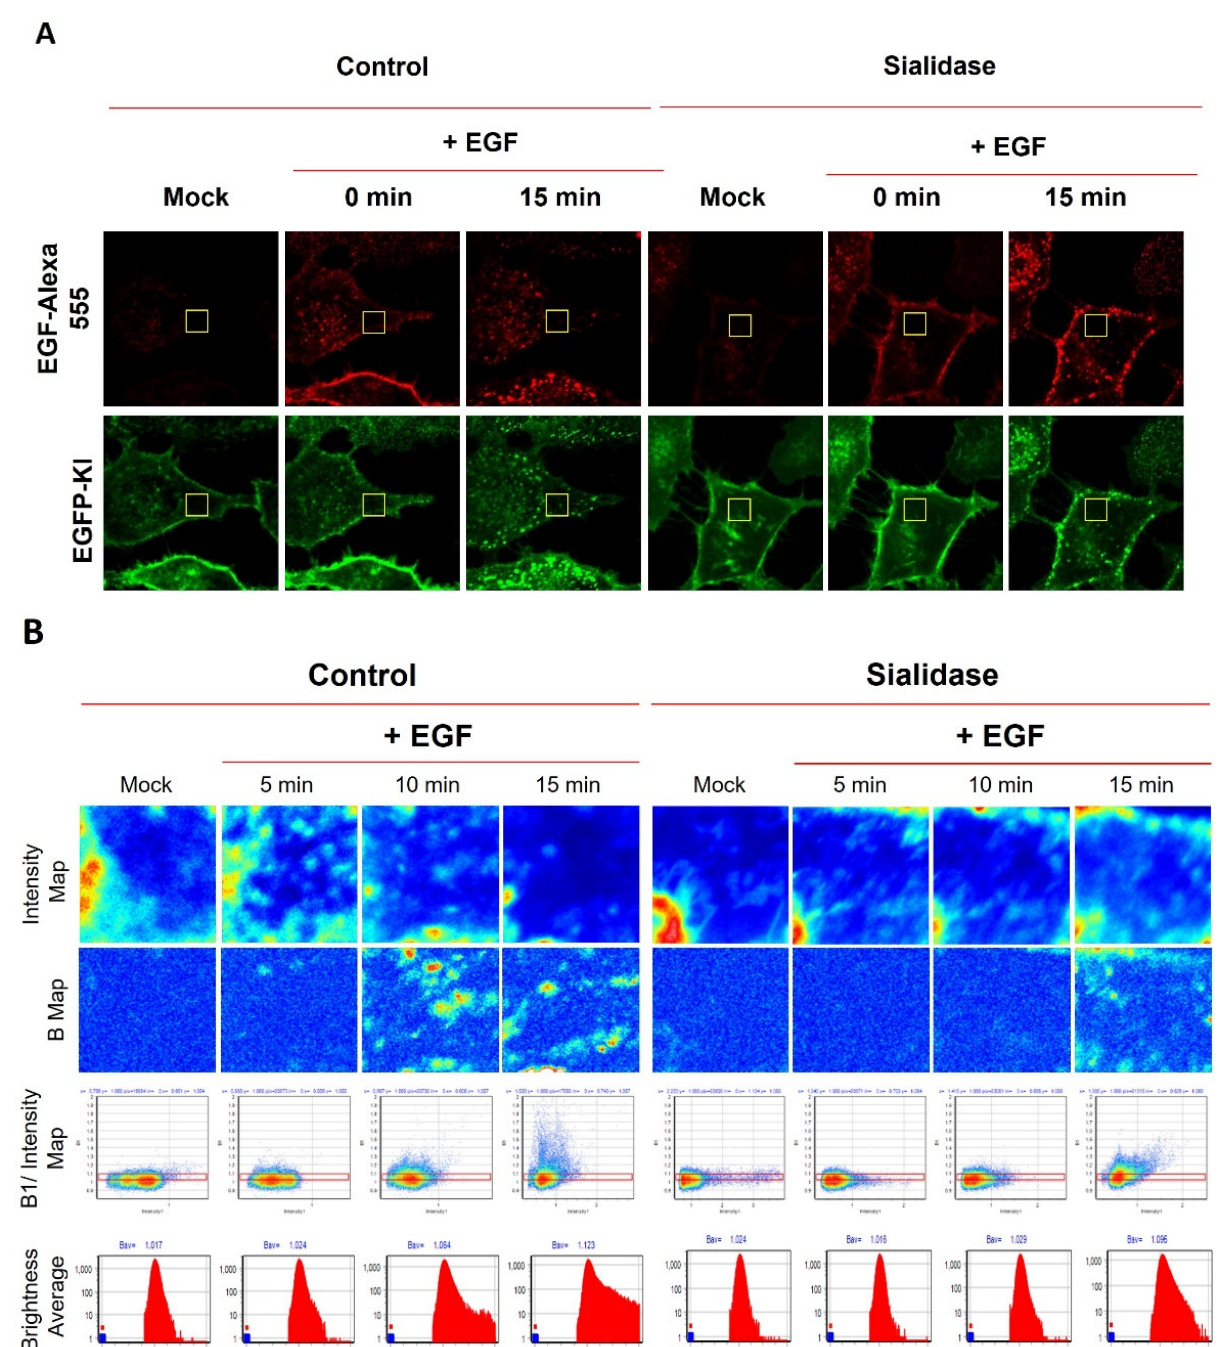
Figure 6. RICS measurement and N&B analysis of EGF-induced EGFR-GFP clustering in EGFP-KI cells treated with and without sialidase. ( A ) Confocal fluorescence images of EGFP-KI cells treated with and without sialidase prior to EGF stimulation. RICS images of the selected region of interest (ROI; yellow box) were acquired for N&B analysis; ( B ) N&B analysis of the ROI at intervals of 5 min after EGF treatment in the control and sialidase-treated EGFP-KI cells. The red boxes in the intensity maps represent monomeric EGFR-GFP defined by the mock control group for ease of comparison